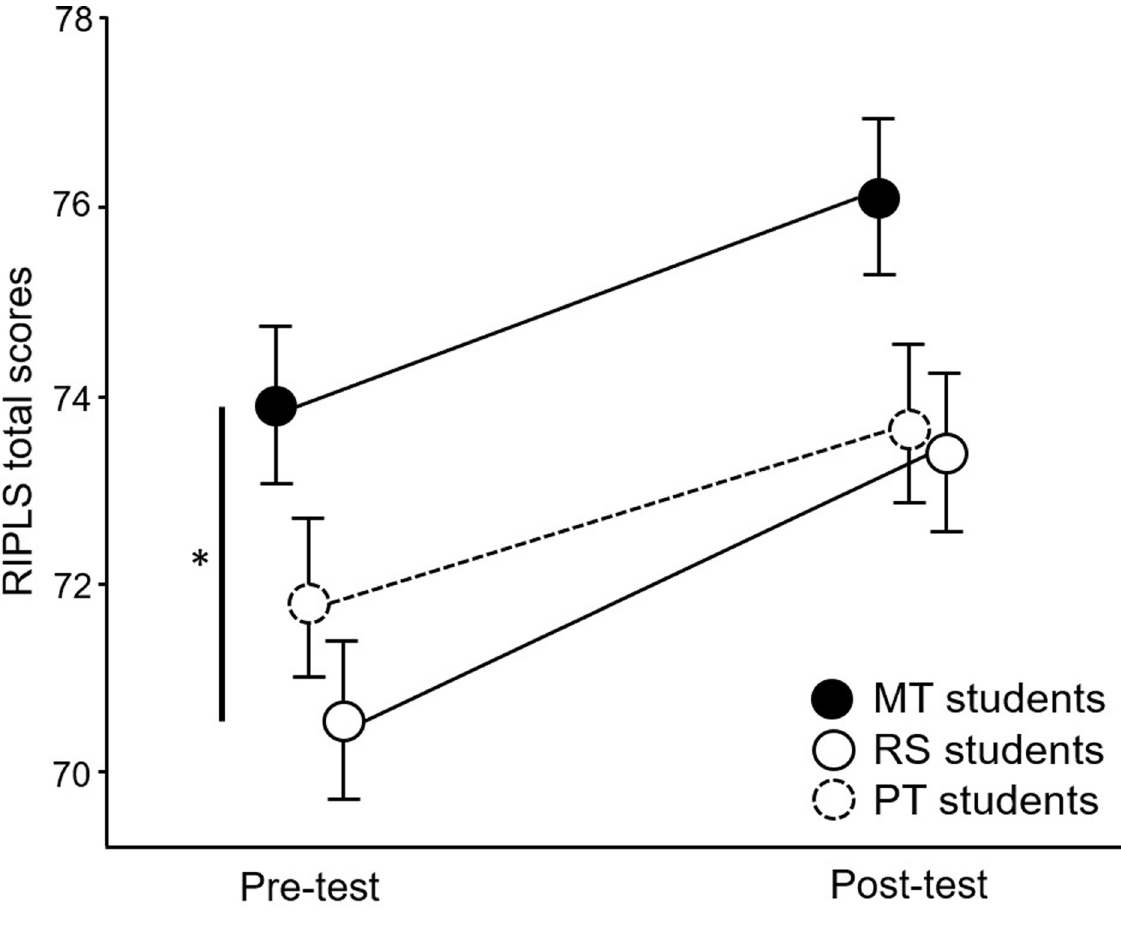
Fig 2. Pre and post-workshop RIPLS total